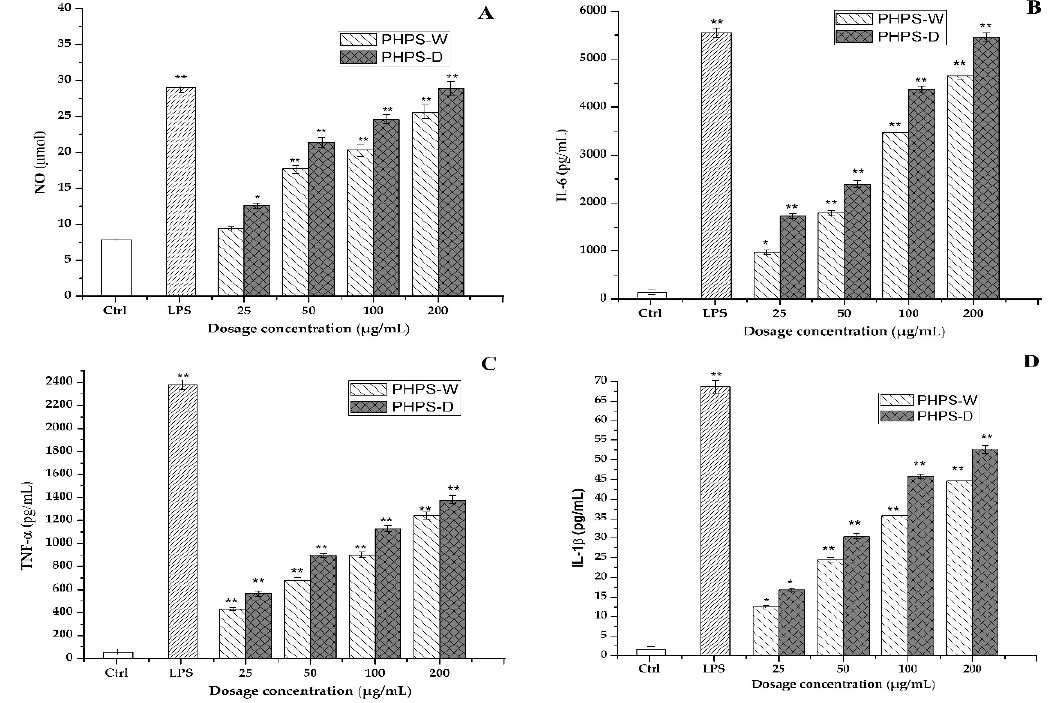
Figure 10. Effect of PHPS-D and PHPS-W treatments on the secretion levels in the RAW264.7 cells of NO ( A ), IL-6 ( B ), TNF- α ( C ), and IL-1 β ( D ). Note: Each experiment was tested in triplicate, and